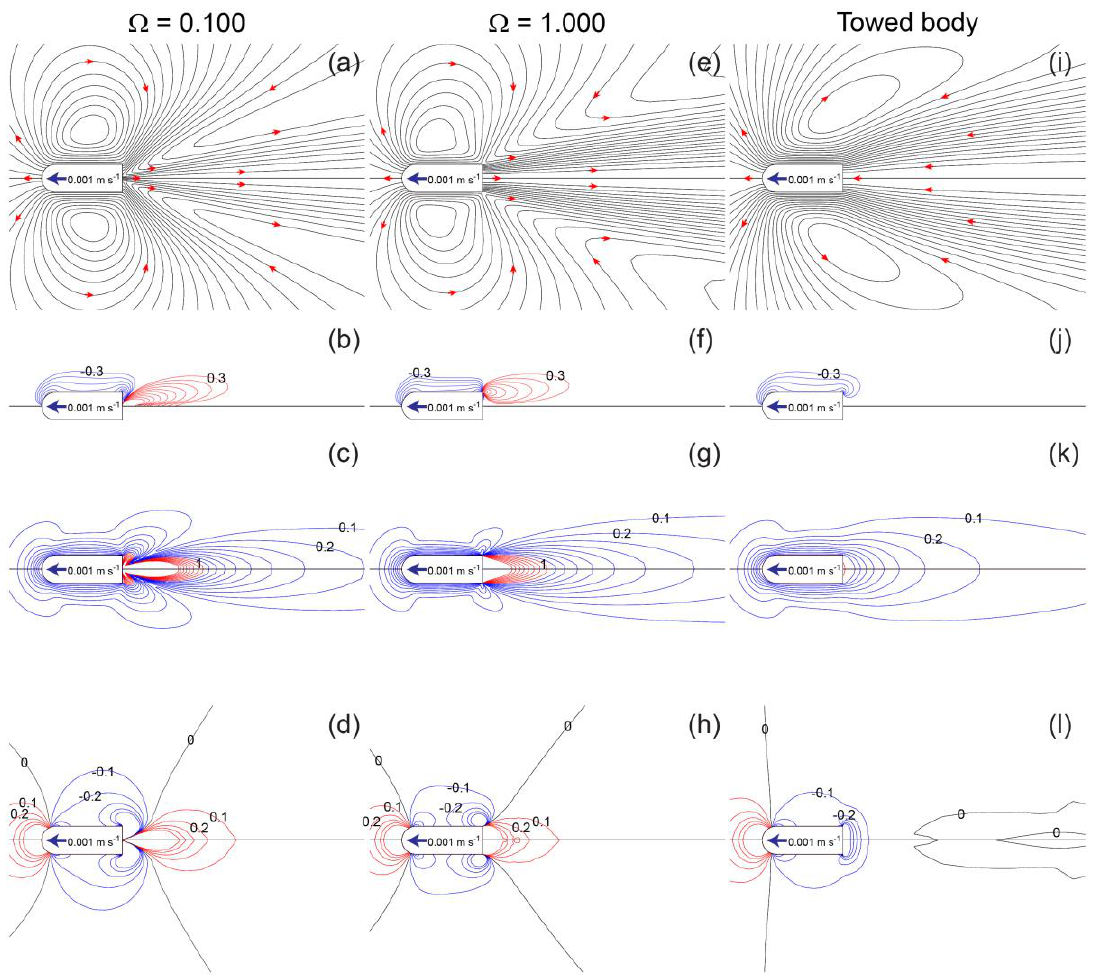
Figure 4. Re = 18.9. CFD-simulated flow fields imposed, respectively, by the jet-propelled body R3-S ( a – d ) and R3-B ( e – h ) and by the towed body T3 ( i – l ), all of which move steadily at U = 0.001 m s −1 . ( a , e , i ) Streamline patterns in a stationary frame of reference. ( b , f , j ) Contours of azimuthal vorticity scaled by 2 U / d ; red contour levels are 0.300, 0.443, 0.654, 0.965, 1.420, 2.100, 3.110, 4.590, 6.770, and 10.000; blue contour levels are −0.300, −0.443, −0.654, −0.965, −1.420, −2.100, −3.110, −4.590, −6.770, and −10.000. ( c , g , k ) Contours of velocity magnitude in a stationary frame of reference and scaled by U ; red contour levels start from 1.0 with increment 0.1; blue contour levels start from 0.1 to 0.9 with increment 0.1. ( d , h , l ) Contours of pressure scaled by 0.5 ρ U 2 ; red contour levels start from 0.1 with increment 0.1; blue contour levels start from − 0.1 with increment −0.1; black contour lines are 0.